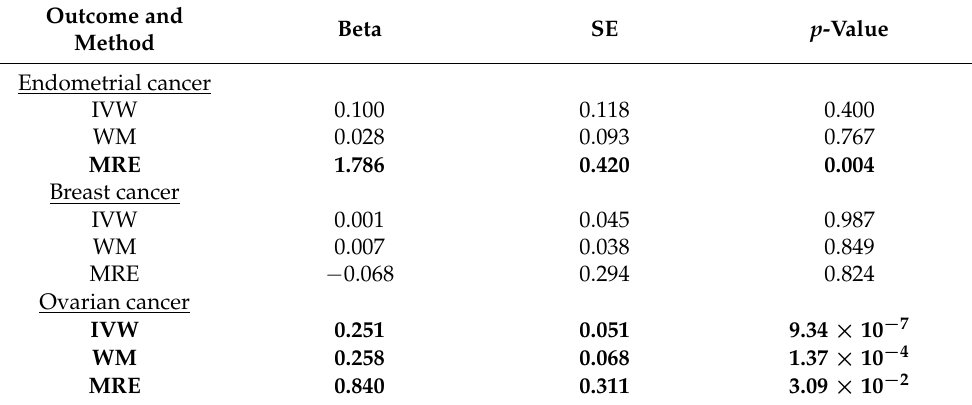
Table 1. Global 2SMR estimates between endometriosis endometrial, breast and ovarian cancers, using the Sapkota et al. endometriosis GWAS as exposure. Estimates were calculated using the inverse variance weighted (IVW), weighted median (WM), MR-Egger (MRE) methods. Beta (log Odds Ratio), standard error (SE) and p -values are indicated. Significant associations ( p -value < 0.05) are highlighted in